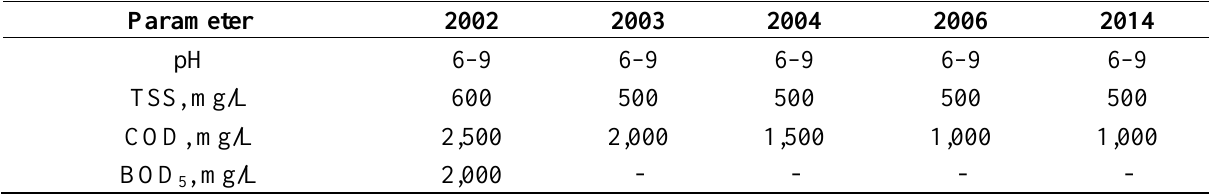
Table 3. Parametric standard limits for discharge of OMW in suitable terrains (data from the Guadalquivir Hydrographical Confederation, 2006–2014)